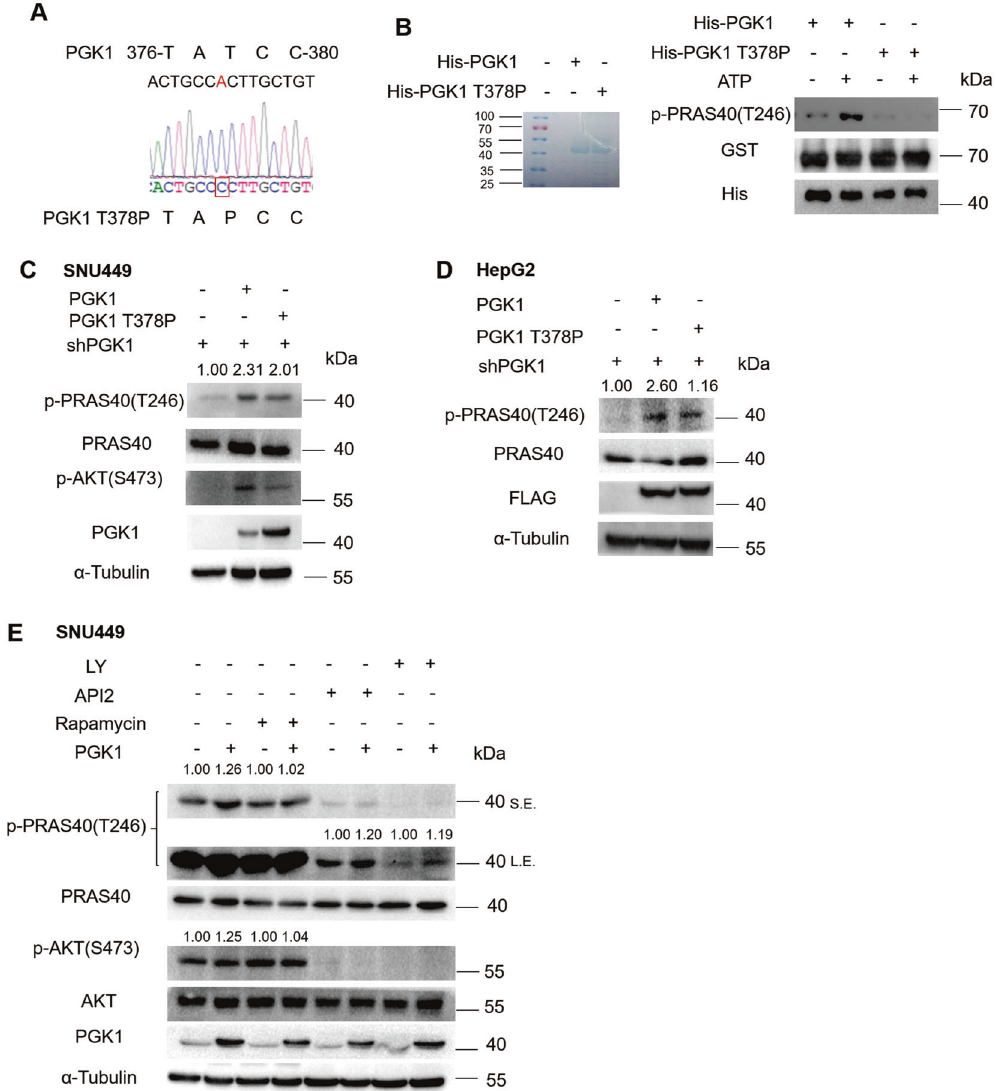
Fig. 2 Correlation of PRAS40 phosphorylation with kinase PGK1. A Sequencing result of a kinase-de fi cient mutant PGK1 T378P. The mutated nucleic acid was framed with a red box. B Coomassie blue staining image for the gel loaded with puri fi ed His-PGK1 or His-PGK1 T378P (left panel). Kinase assays using GST-PRAS40 together with His-PGK1 or His-PGK1 T378P (right panel) followed by western blotting analyses with the indicated antibodies. C – E Western blotting analyses with the indicated antibodies. The cells depleted with PGK1 were introduced with empty vector, shRNA-resistant FLAG-PGK1, or FLAG-PGK1 T378P expression vector ( C, D ). The indicated cells were treated with rapamycine (50 μ M), API2 (100 μ M), or LY294002 (50 μ M) for 1 h ( E ). The quanti fi cation results of the band density were labeled above the